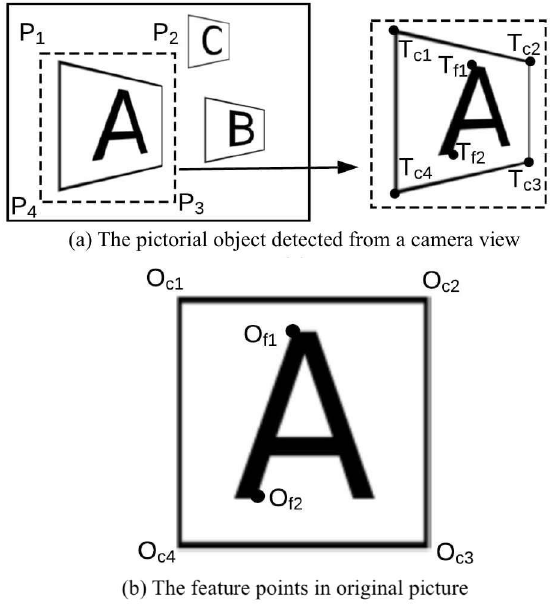
Figure 7. PicPose Feature